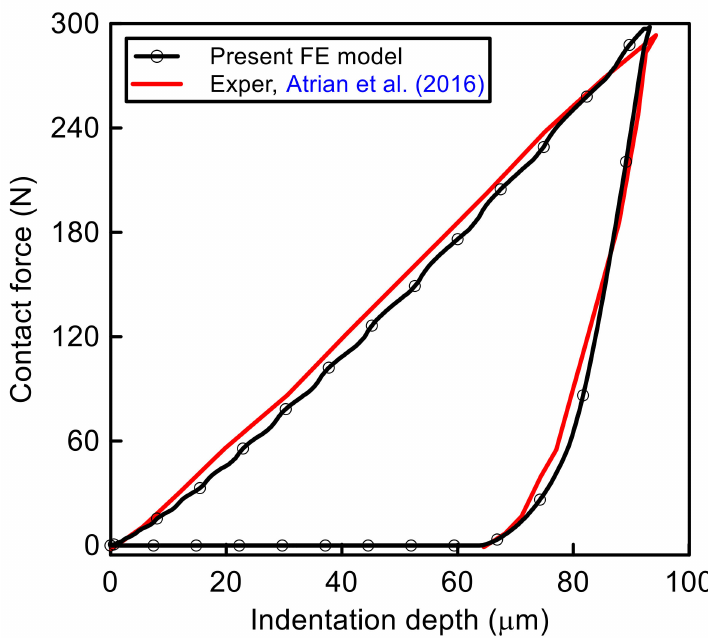
Figure 4. Validation of the present FE model with the experimental results of elastoplastic composite